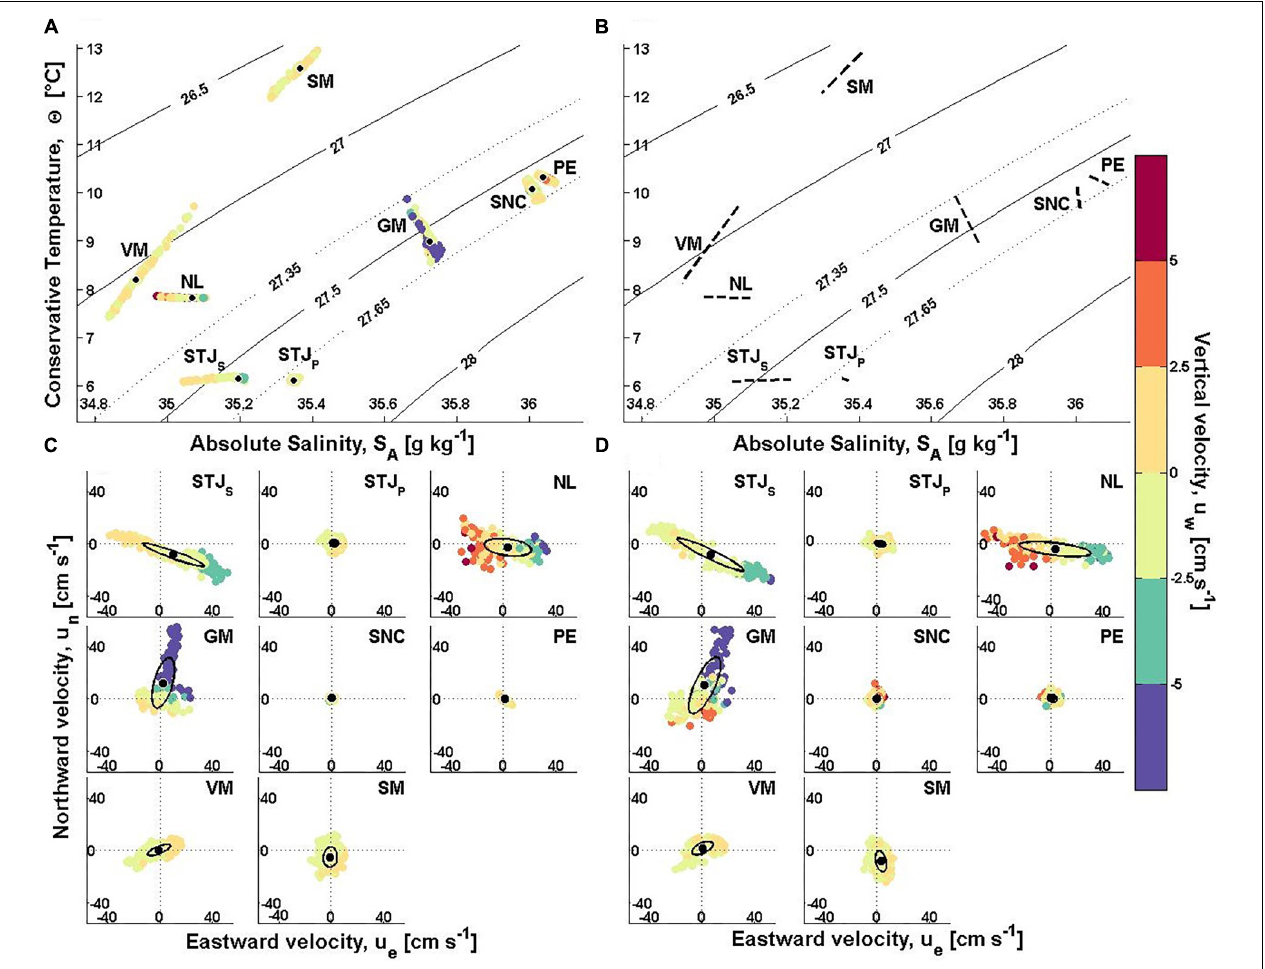
FIGURE 7 | Hydrographic and velocity data from lander deployments. (A) (cid:50) S A -u w plot (negative values upward). The mean (cid:50) , S A –values are marked with black dots. (B) The maximum density change within one tidal cycle (back dashed lines). The sigma-theta range 27.35–27.65 kg m - 3 from Dullo et al. (2008) marked with dotted lines in panel (A,B) . Horizontal velocity from 8 masf (C) and 35 masf (D) with variance ellipses (black ellipse) and mean velocity (black dot). Color scale shows the vertical velocity as in panel (A) . Axis scale is ± 50 cm s - 1 in panel (C,D) . STJ S , Stjernsund CWCs; STJ P , Stjernsund reference; NL, Nordleksa; GM, Galway Mound; SNC, St. Nazaire Canyon; PE, Pagés Escarpment; VM, Valentine Mound; SM, Sylvester